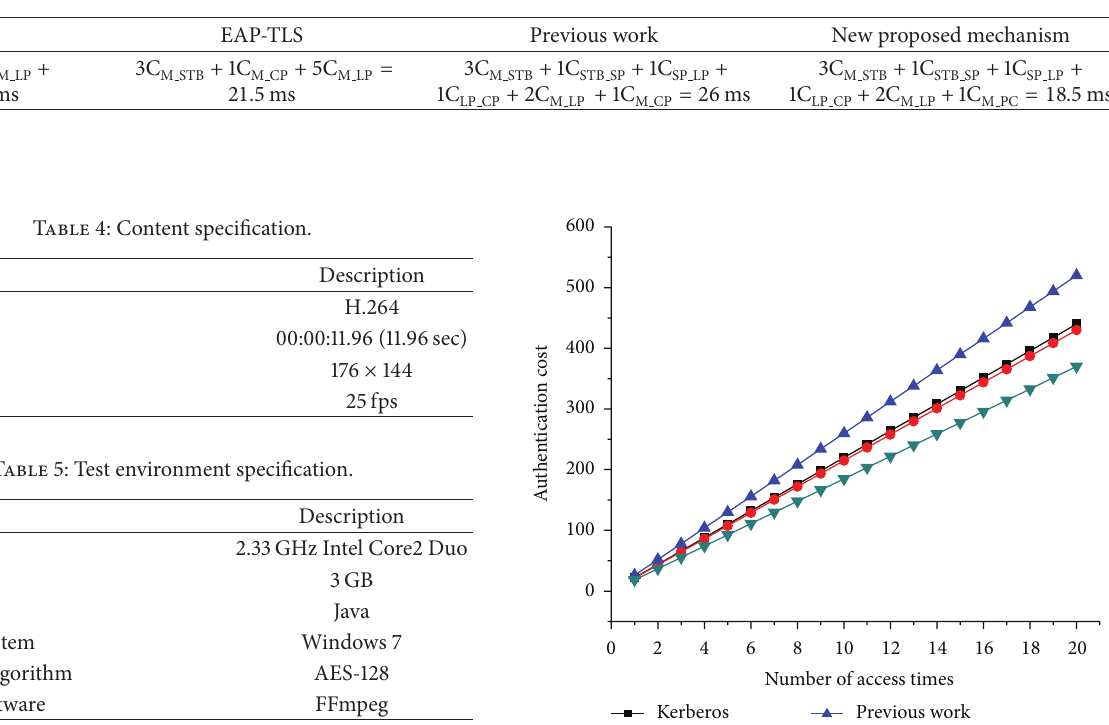
Table 3: Estimation of the authentication cost of Kerberos, EAP-TLS, and proposed authentication mechanism.